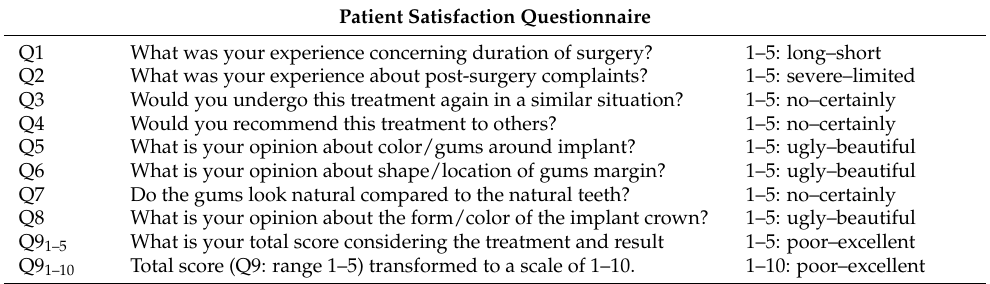
Table 1. Patient Satisfaction Questionnaire.